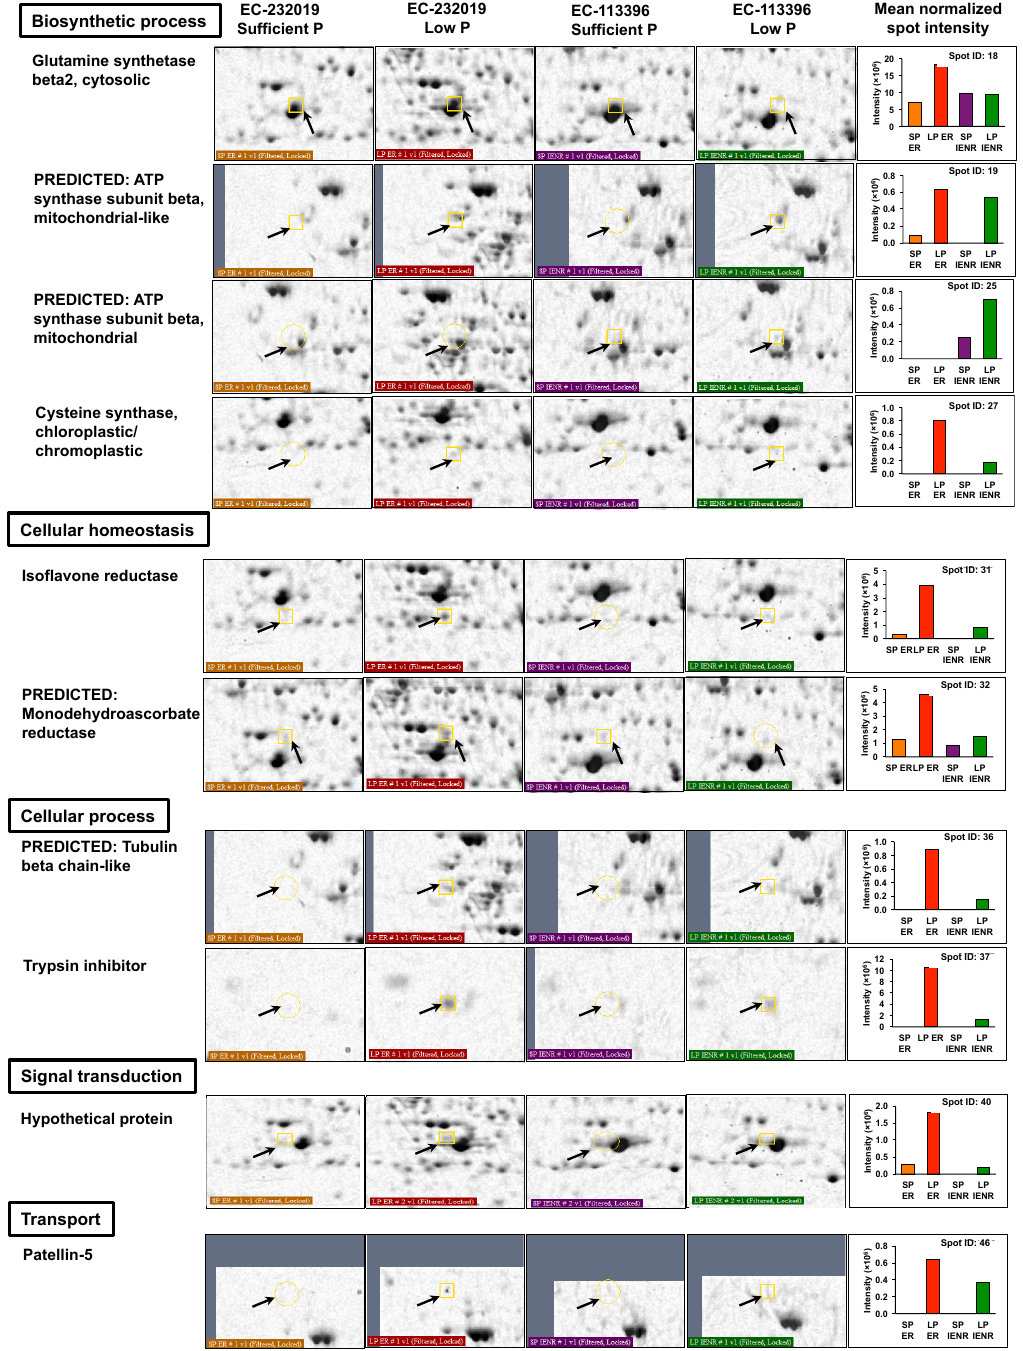
Figure 4. Root proteins increased by more than two-fold at low (4 µ M) P in contrasting soybean genotypes. Arrows denote the protein spots zoomed for better visualization. Bars in the graph denote the mean ( n = 3) normalized intensity of protein spots on gels of EC-232019 Sufficient P (orange, SP ER), EC-232019 Low P (red, LP ER), EC-113396 Sufficient P (violet, SP IENR) and EC-113396 Low P (green, LP IENR). Proteins with significant Mascot score are presented here. Refer Table 1 for entire list of increased